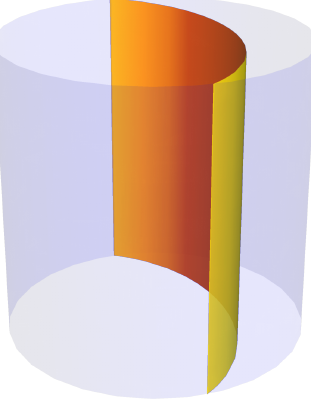
Figure 1. An AdS 2 brane in AdS 3